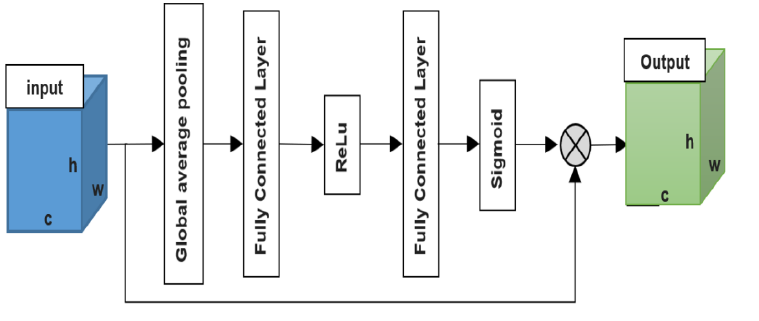
Figure 3. Squeeze and excitation structure.